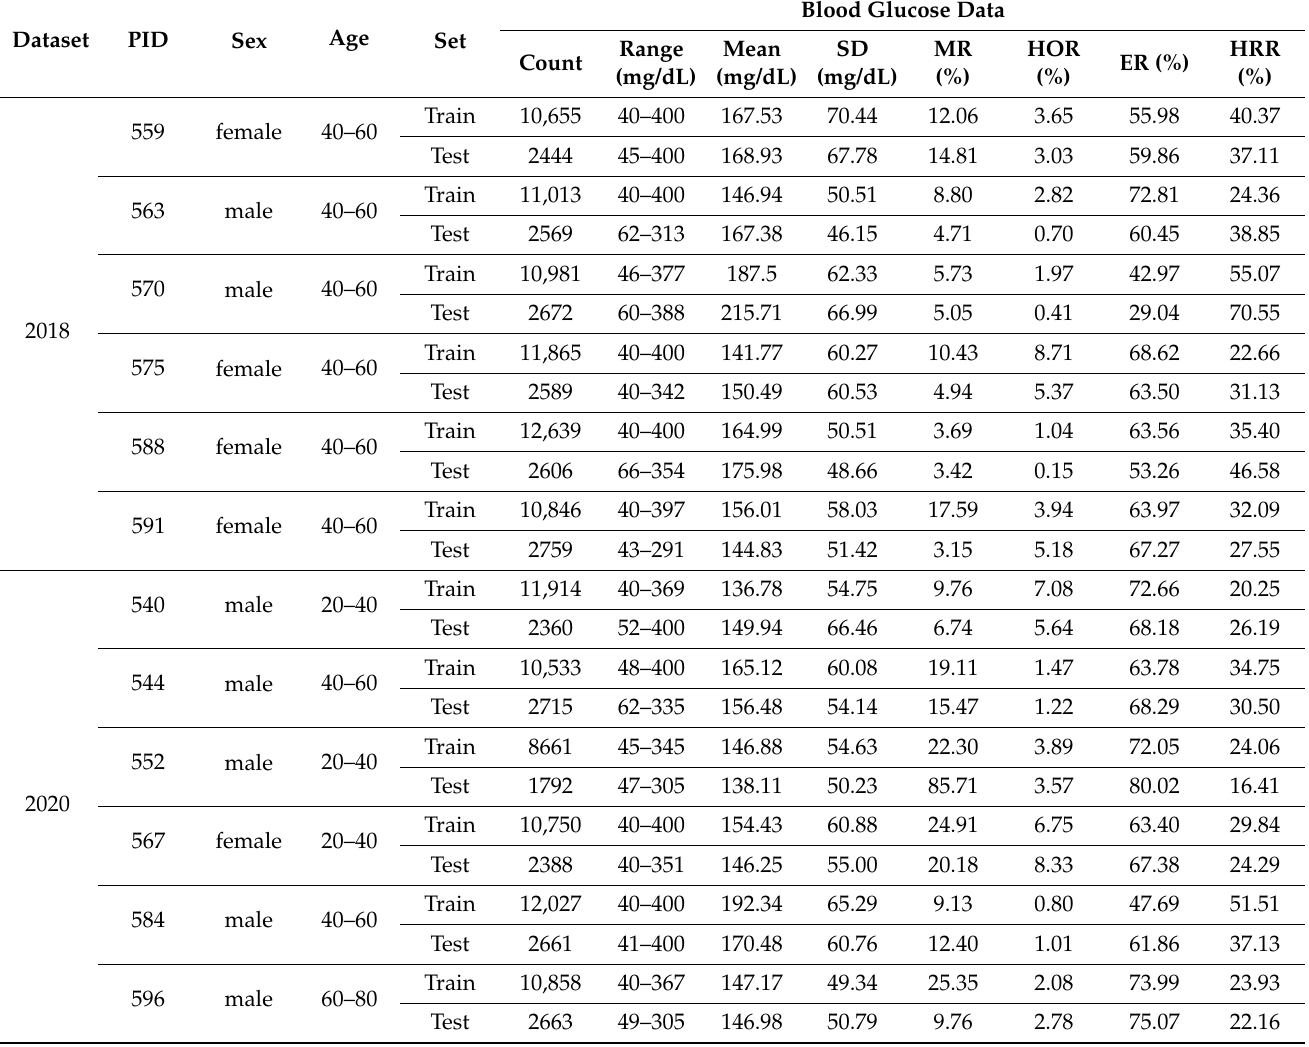
Table 1. Demographic information of contributors and summary of statistical properties of blood glucose data (the focal modality) in the Ohio